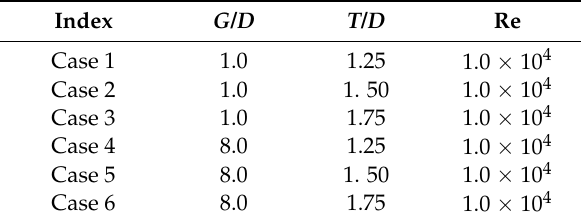
Table 1. Simulation cases for flow over two side-by-side cylinders. Re: Reynolds